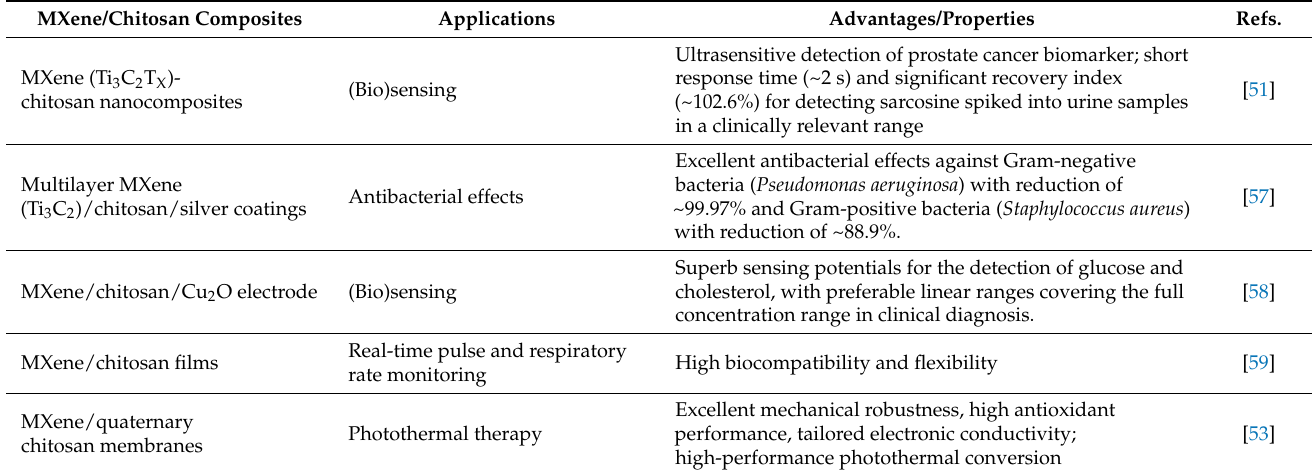
Table 1. Some selected examples of MXene-chitosan composites and their